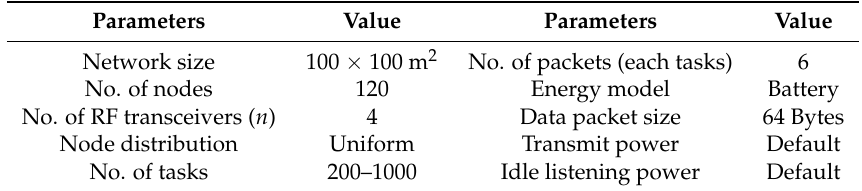
Table 4. Some key simulation